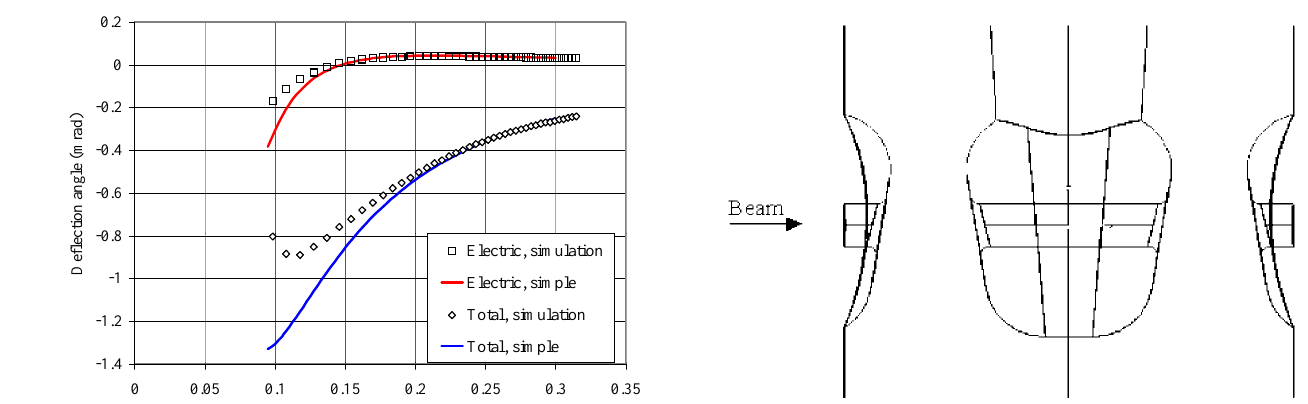
FIG. 8. 115 MHz QWR with modified shapes of drift tubes.